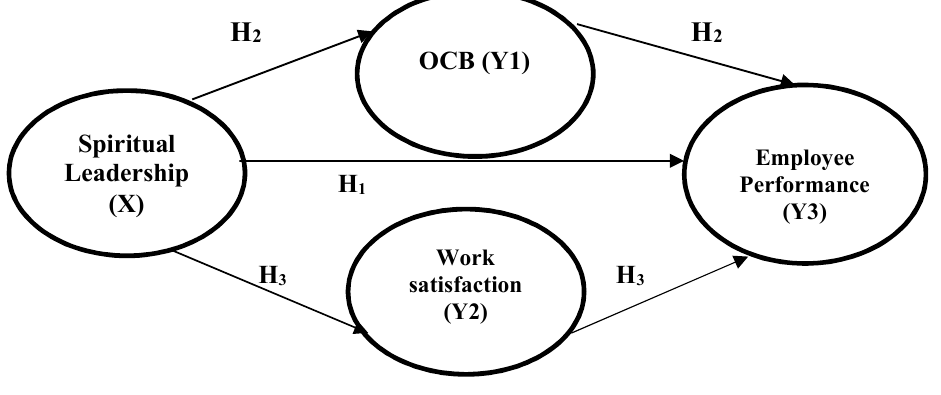
Fig. 1. Model of Research Hypotheses